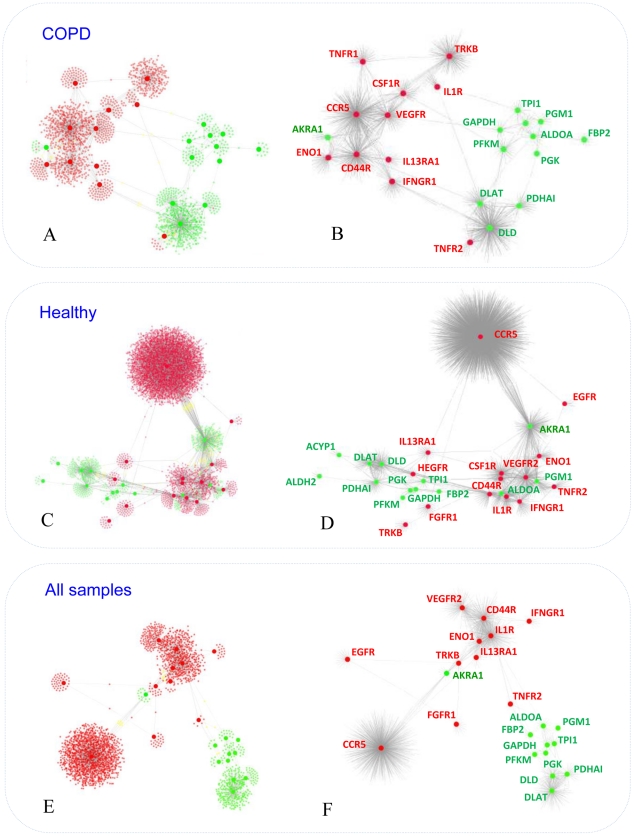
Healthy and COPD specific networks.The figure shows interaction networks built using solely expression profiling data representing healthy (panels A and B) or COPD (panels C and D) muscle biopsy mRNA profiles. For comparison with Figure 1, the network representing integrated healthy and COPD samples has been represented in Panels E and F. Figure layout and the colour coding are identical to Figure 1.